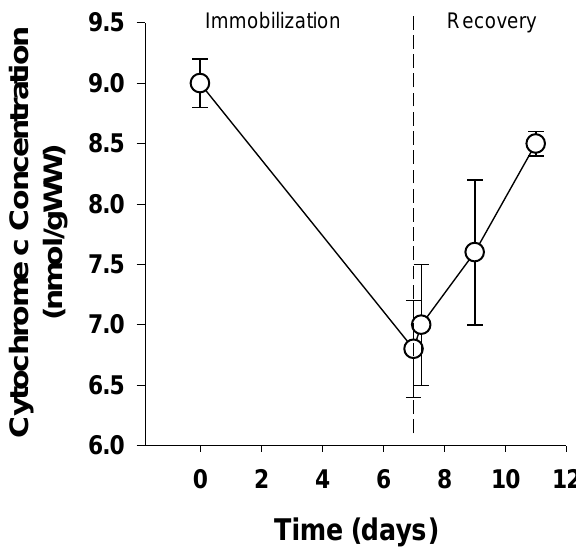
Figure 3. Role of inactivity on mitochondrial fractional volume adapted from Morrison et al. 1987. Rat quadricep muscles were immobilized by cast for 7 days and mitochondrial fractional volume determined from cytochrome c content. Measures were taken from muscle samples before immobilization and at time points 0-, 0.25-, 2-, and 4-days following cast-removal.